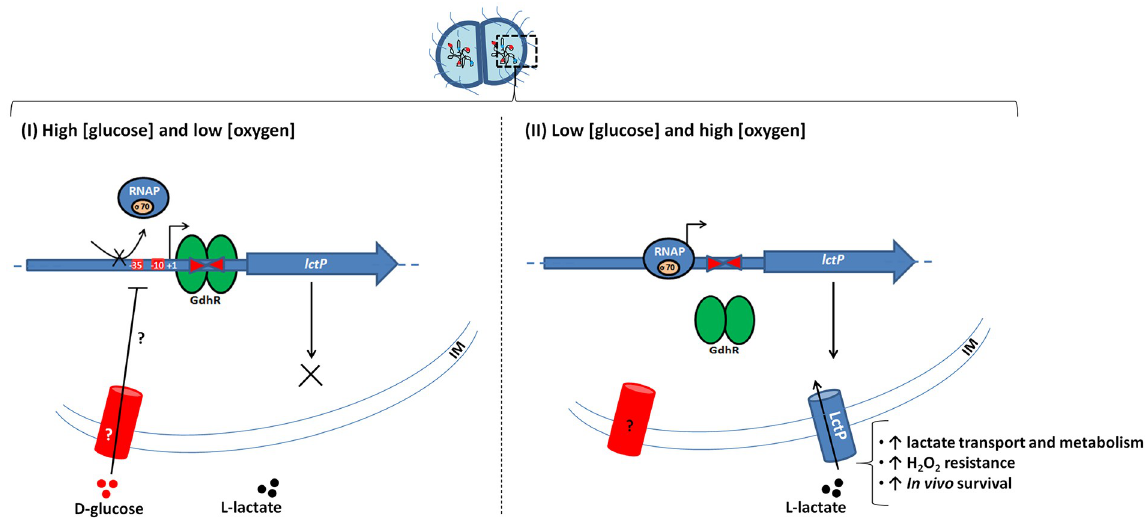
Fig 9. Hypothetical model for the regulation of N . gonorrhoeae lctP and implications for pathogenesis (based on our data and results published by others, see Discussion). (I) Under conditions of D-glucose availability and low oxygen tension ( i . e . those within a biofilm) the GntR-type regulator GdhR binds to an inverted repeat sequence located 9 bases downstream the TSS (+1). This binding results in transcriptional repression of lctP possibly by creating a steric hindrance to the RNA polymerase (RNAP) recognition of the promoter elements (-35 and -10). The presence of D-glucose in the extracellular milieu results in additional repression of lctP by an unknown GdhR-independent mechanism. In N . gonorrhoeae the glucose permease is unknown as wells as any phosphotransferase system involved in carbon catabolite repression. (II) Under conditions of low glucose concentration and oxygen availability ( i . e . those within the neutrophil phagosome) the lctP promoter is released from glucose and GdhR repression to reach maximal expression. This increases L-lactate transport and metabolism which results in increased resistance to hydrogen peroxide and survival in vivo . Under this condition (oxygen availability or oxidative stress such as hydrogen peroxide treatment), expression of lldD , encoding L-lactate dehydrogenase, is also increased.